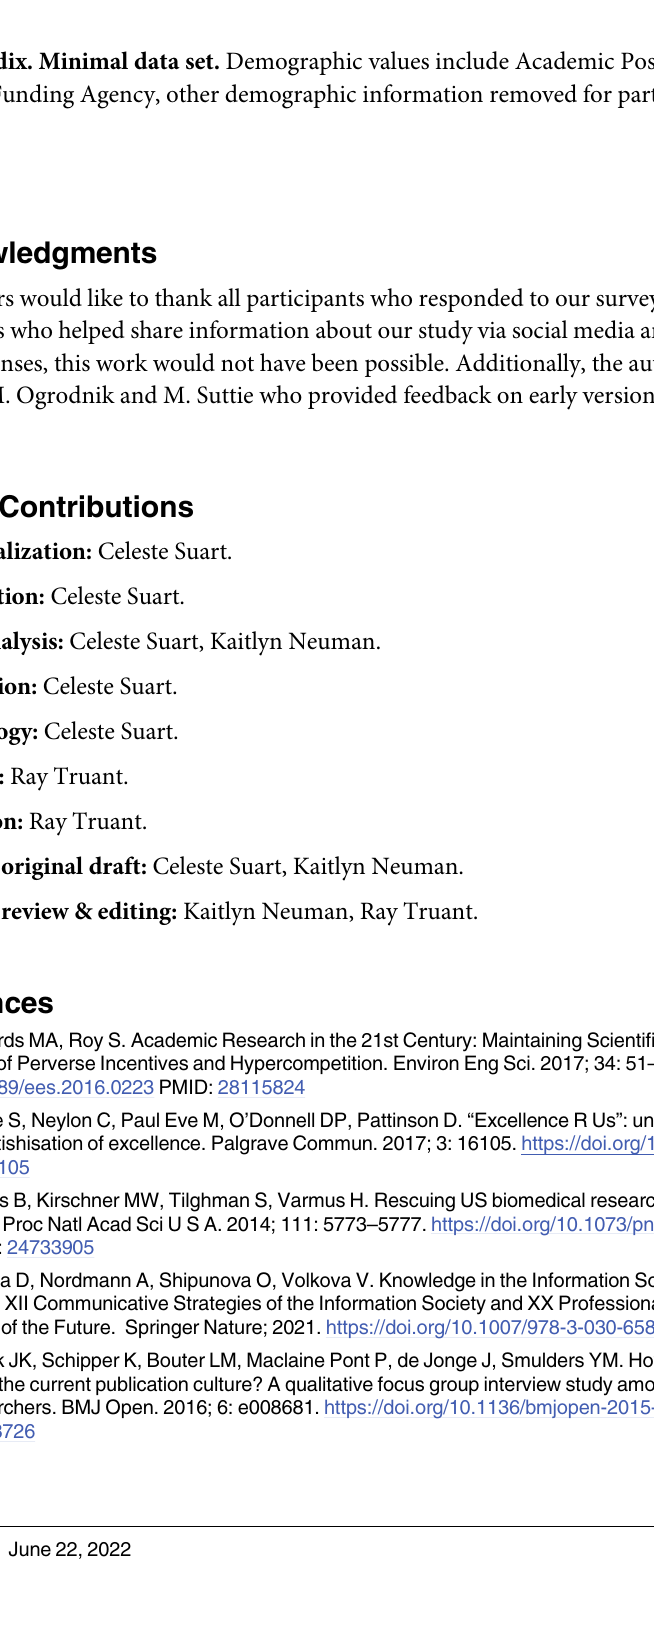
S8 Table. Publication pressure questionnaire subscale scores stratified by ethnicity. Values represent mean score with standard deviation in